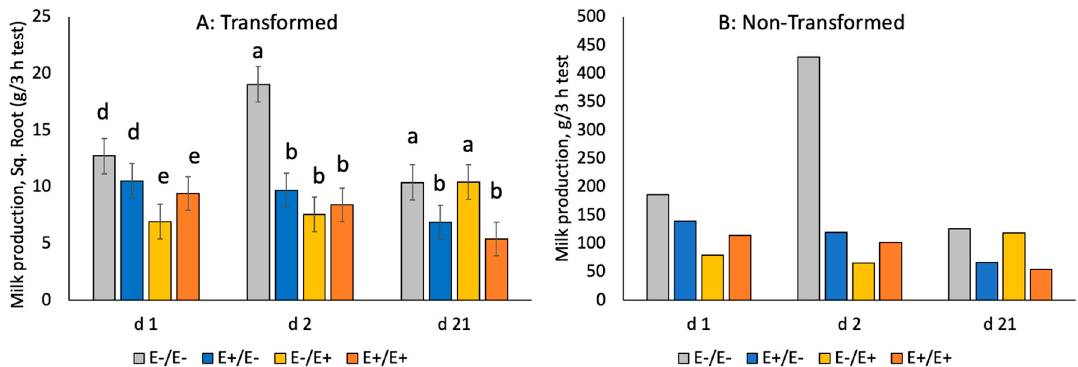
Figure 6. Milk production (g / 3 h test) in ewes fed E − or E + seed in MID or LATE gestation. Superscripts denote significance ( a,b p < 0.05; d,e p < 0.10) by day of lactation. Milk production data were not normally distributed and were square-root-transformed for statistical analyses ( A ). Actual means, non-transformed, are also presented for easier understanding and interpretation ( B ).